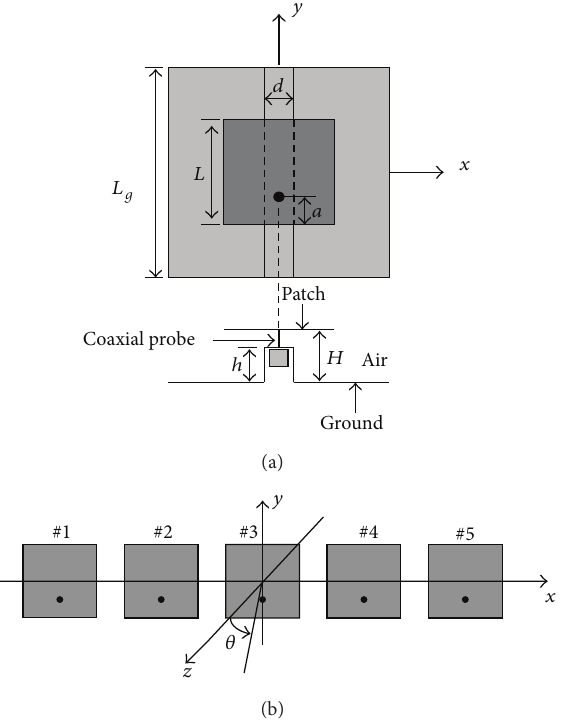
Figure 2: Microstrip element profile (a) and array structures (b). = 90 mm, 𝑑 = 8 mm, 𝑎 = 12 mm, 𝐿 = 50 mm, 𝐻 = 15 mm, and 𝐿 𝑔 ℎ = 12 mm.